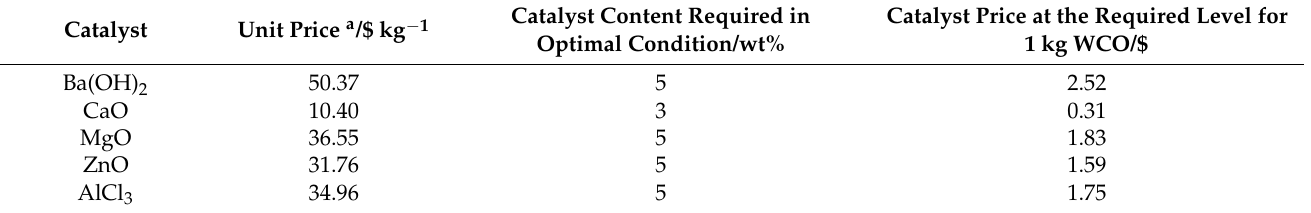
Table 3. Analysis of the prices of the heterogeneous catalysts under optimal